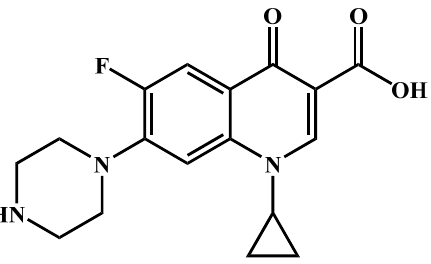
Figure 1. The atomic structure of CIP.